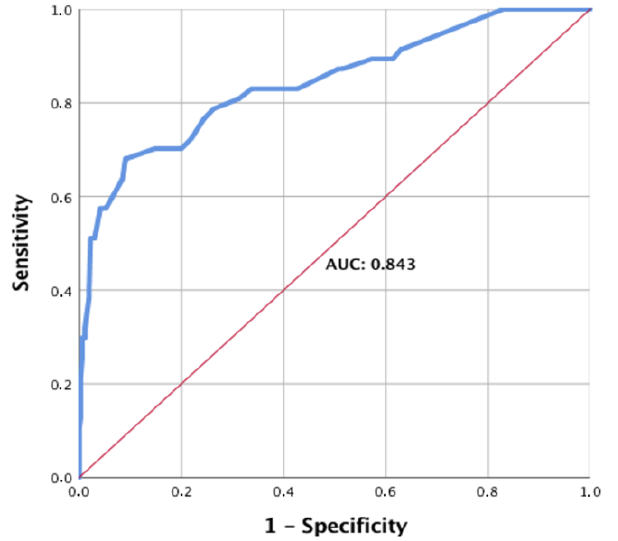
Figure 1. ROC (receiver operating characteristic) for predicting urogenital injuries in polytrauma patients. The ROC (receiver operating characteristic) for use of the above scoring system in predicting urogenital injuries in polytrauma patients, the AUC (area under the curve) is 0.843. The area under the curve (AUC) was 0.843 with a confidence interval of (0.77; 0.91), showing high prediction strength. Additionally, an assessment of the scoring system was performed, comparing the prediction with the actual scores (Figure 2).